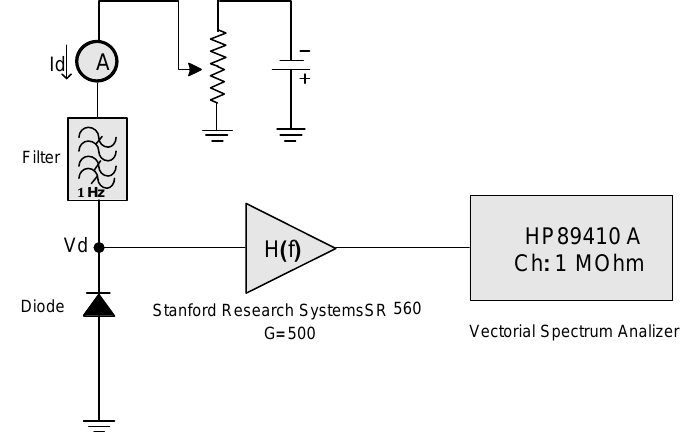
ff erent DC biases. Figure 13. Setup to evaluate low-frequency noise under different DC biases.